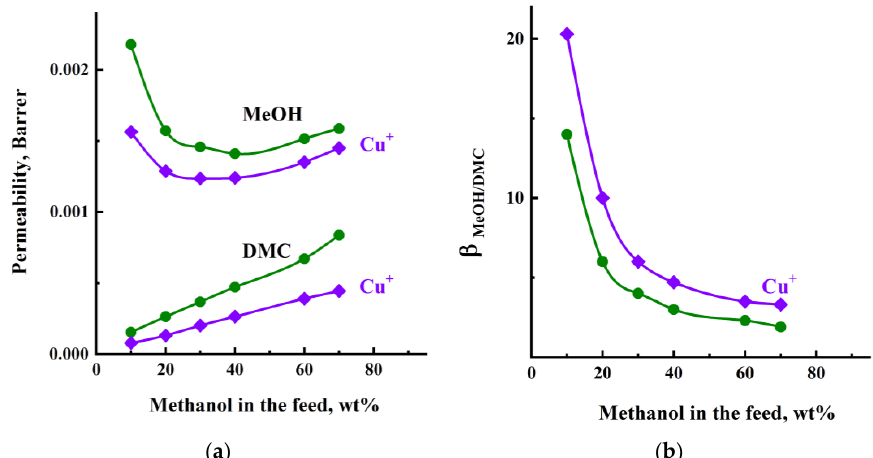
Figure 10. ( a ) Permeability of methanol and DMC and ( b ) selectivity ( β MeOH/DMC ) vs. methanol concentration in the feed for pervaporation through the (1, 1 (cid:48) ) PHI and (2, 2 (cid:48) ) PHI-Cu(I) membranes, 40 °C.